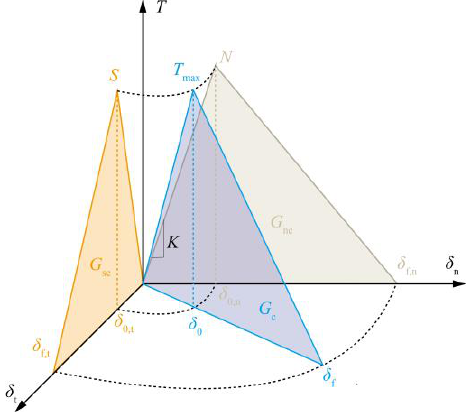
Figure 1. A typical bilinear mixed-mode traction-separation law for CZM. When the equivalent displacement δ e =